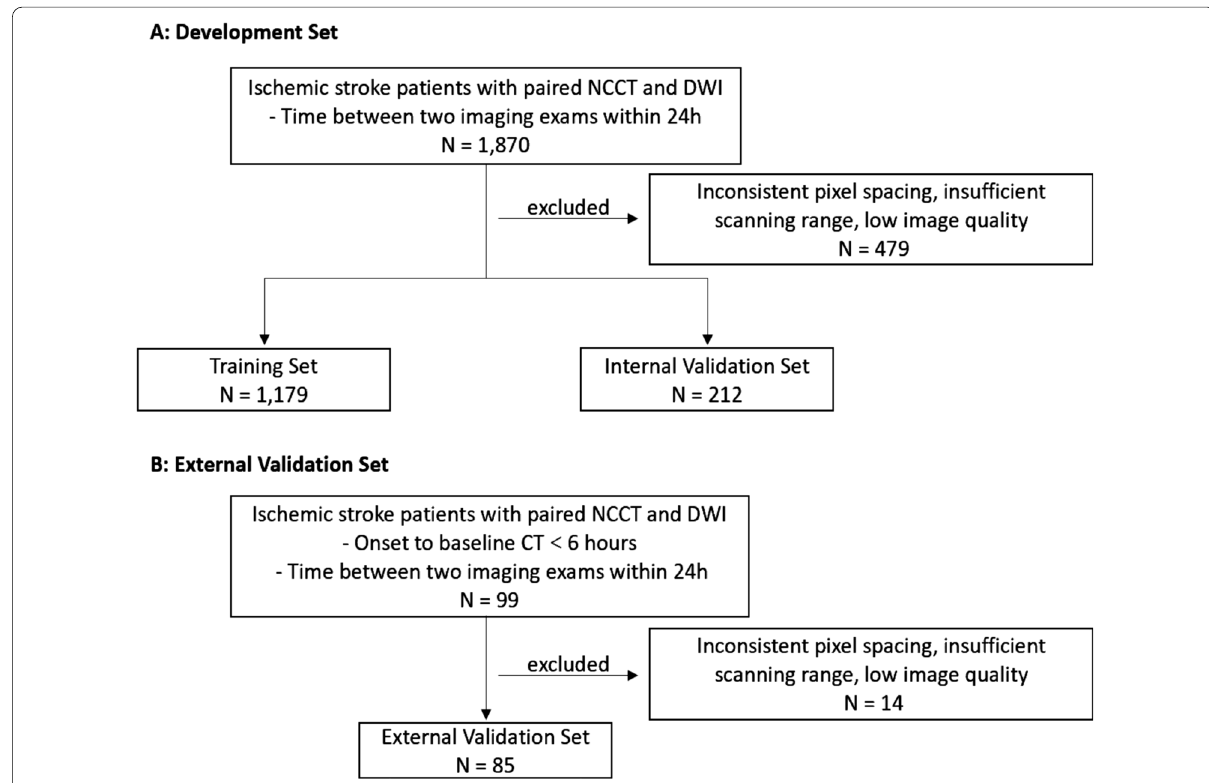
Fig. 1 Flowchart of data